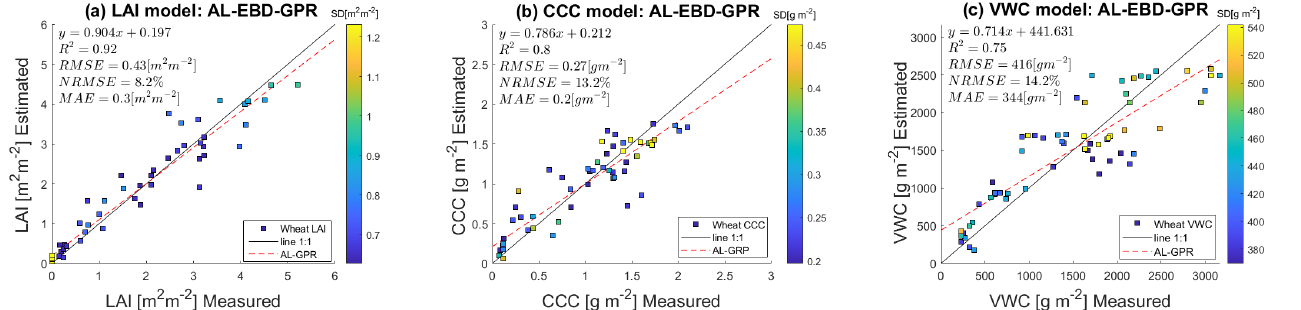
Figure 6. Measuredvs. estimated wheat traits along 1:1-line including uncertainty intervals, using the EBD-optimised training data set. ( a ) LAI model estimates; ( b ) CCC model estimates; ( c ) VWC model